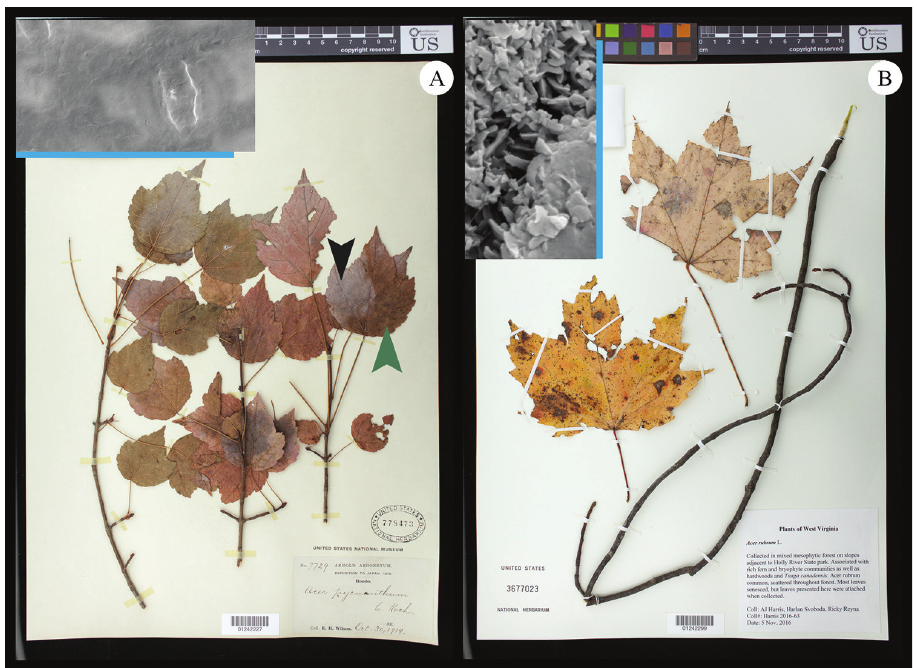
Figure 7. Late-season specimens of Acer sect. Rubrum approaching leaf senescence. A A. pycnanthum with black arrow indicating silvery abaxial surface and green arrow indicating non- silvery surface. The inset in the upper left shows an SEM micrograph of a portion of an abaxial leaf surface from this specimen that lacks the silvery color such as the area referred to by the green arrow. Blue scale bar = 50μm. For an SEM micrograph showing a silvery portion of leaf surface from this specimen, see Figure 5C B A. rubrum exhibiting exclusively silvery abaxial leaf surface (upper, right leaf). The inset in the upper left shows an SEM micrograph of a portion of an abaxial leaf surface from this specimen bearing the characteristic sil- very surface, and we did not observe late season leaves of A. rubrum lacking the silvery surface. Herbarium specimens deposited at US, and accession information visible in images. Detailed specimen records are available via the US online catalog